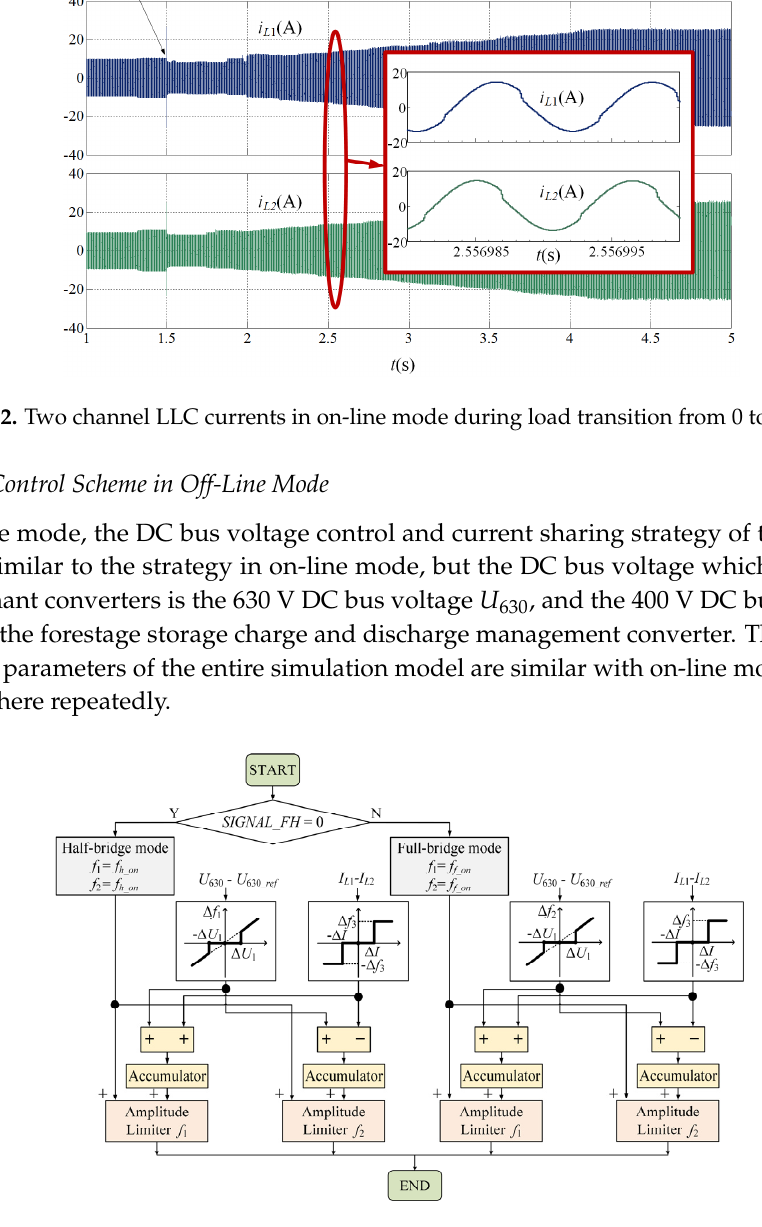
Figure 13. LLC control scheme in off-line mode.